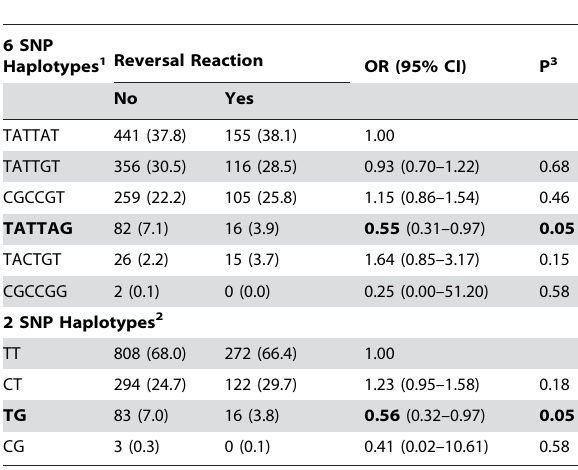
Table 4. Frequency of TLR1 haplotypes in reversal reaction.